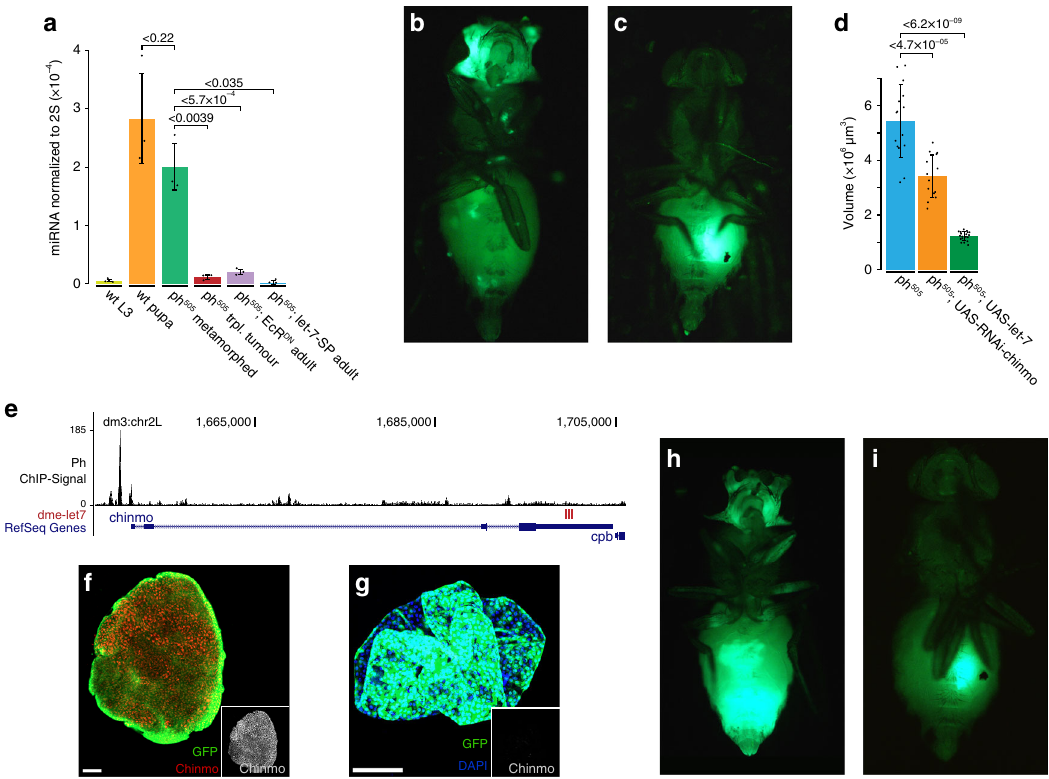
Fig. 3 Ecdysone-induced let-7 and its target Chinmo regulate the growth of ph 505 tumours. a Quantitative PCR analysis of the expression level of mature let- 7 in different samples. Mean of three of total three biological replicates with error bars describing the standard deviation. Statistical signi fi cance is determined by the t -test. b An adult fl y of ph 505 ; UAS-let-7-SP at 2 weeks after eclosion, showing the formation of tumours throughout the body. c Formation of tumours in a wild-type host after transplantation of ph 505 ; UAS-let-7-SP cells dissected from the adult head. d Mean total volume of tumour clones in the eye-antennal discs of the different genotypes. n = 15 ( ph 505 ), 14 ( ph 505 ; UAS-RNAi-chinmo ), and 19 ( ph 505 ; UAS-let-7 ), with error bars denoting the standard deviation. Signi fi cance was assessed using Welch ’ s t -test. e Genome browser view of the chinmo locus, showing Ph ChIP signals at the transcription start site and several let-7 binding sites (red bars) at the 3 ′ UTR. f , g Confocal images of immunostaining with Chinmo antibodies. Chinmo is expressed in the transplanted tumour cells ( f ) but not in the metamorphed ph 505 cells ( g ). Scale bars are 50 μ m. h An adult fl y of ph 505 ; UAS-chinmo at 2 weeks after eclosion, showing the formation of tumours all over the body. i Formation of tumours in a wild-type host after transplantation of ph 505 ; UAS- chinmo cells dissected from the adult head. Genotypes: a , wt: FM7 act-GFP/tub-Gal80 FRT19A; + /ey- fl p act>STOP>Gal4 UAS-GFP ; ph 505 : ph 505